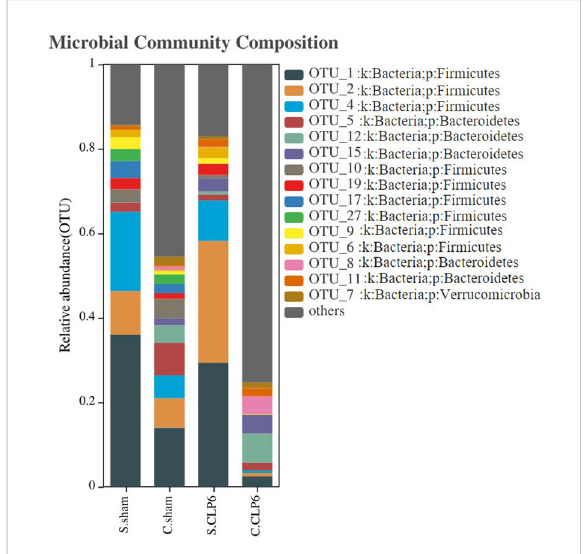
FIGURE 2 Histogram of gut microbiota distribution in four groups. The abscissa represents the groupings, and the ordinate represents the gut microbiota abundance values. The taxa with an abundance above 1% were selected, and all abundances were in the top 15 for classi fi